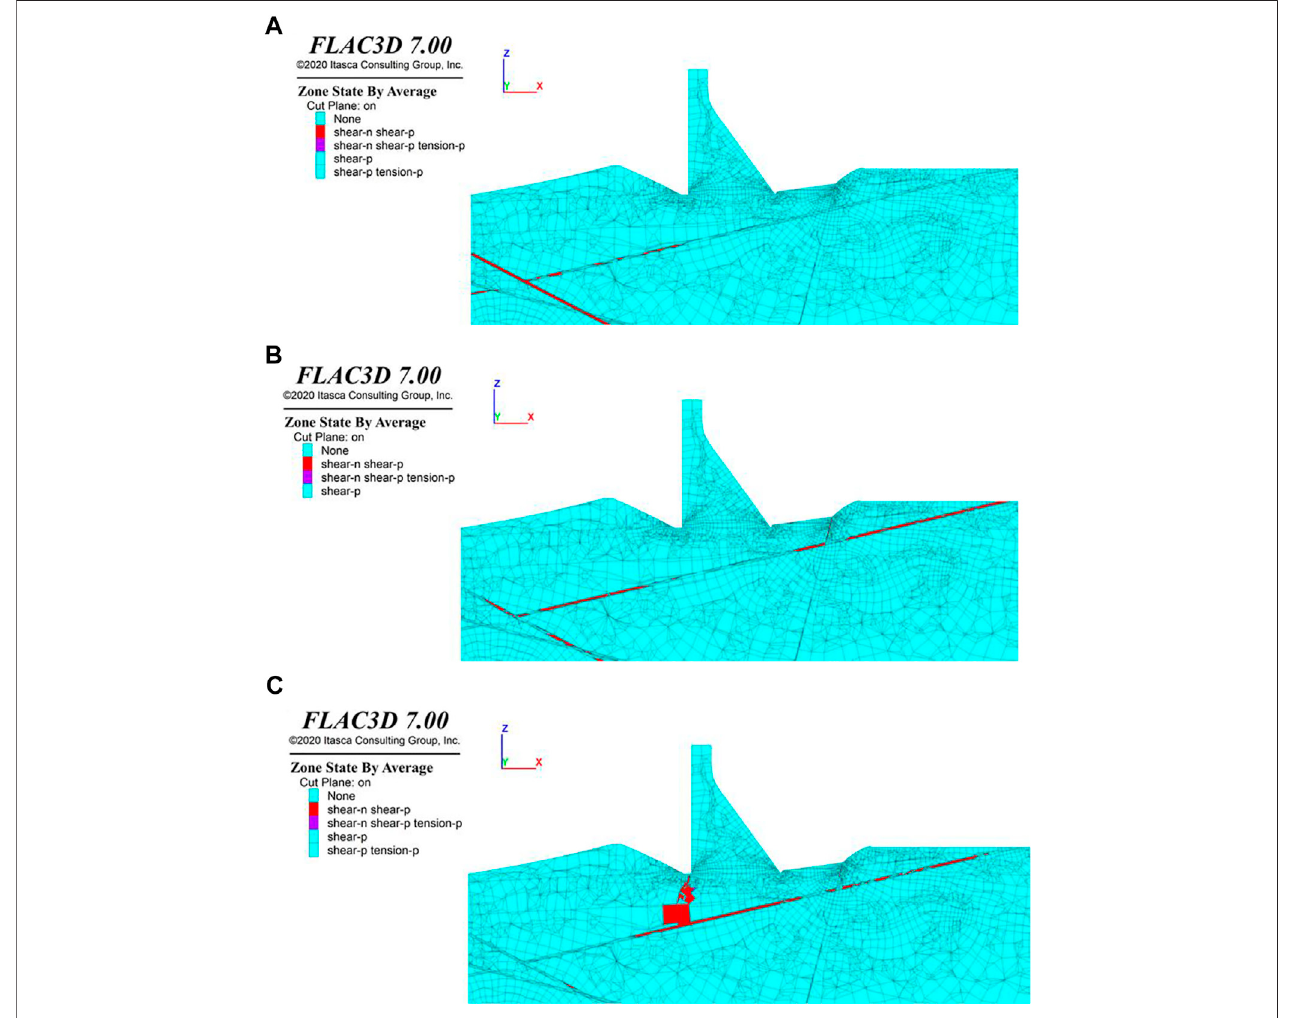
FIGURE 13 | Plastic zones in the pro fi le cutting through the center of dam section 9 under the conditions of (A) SRF = 2.0, (B) SRF = 2.2, and (C) SRF = 2.5.